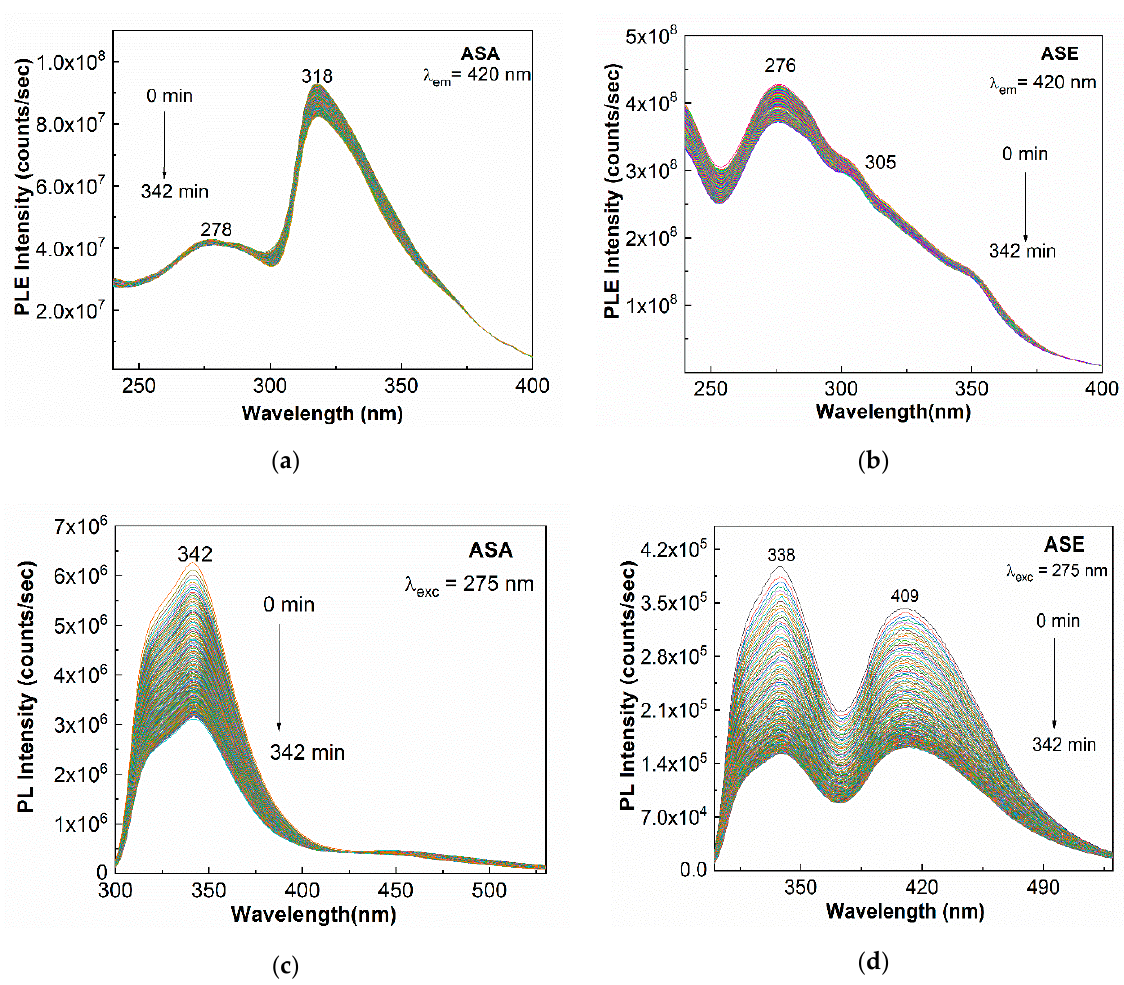
Figure 1. Photoluminescence excitation (PLE) spectra of ASA ( a ) and ASE ( b ), in powder state, recorded at the emission wavelength equal to 420 nm. Photoluminescence (PL) spectra of acetylsalicylic acid (ASA) ( c ) and pharmaceutical product containing acetylsalicylic acid in the presence of excipients (ASE) ( d ), in powder state, recorded at the excitation wavelength equal to 275